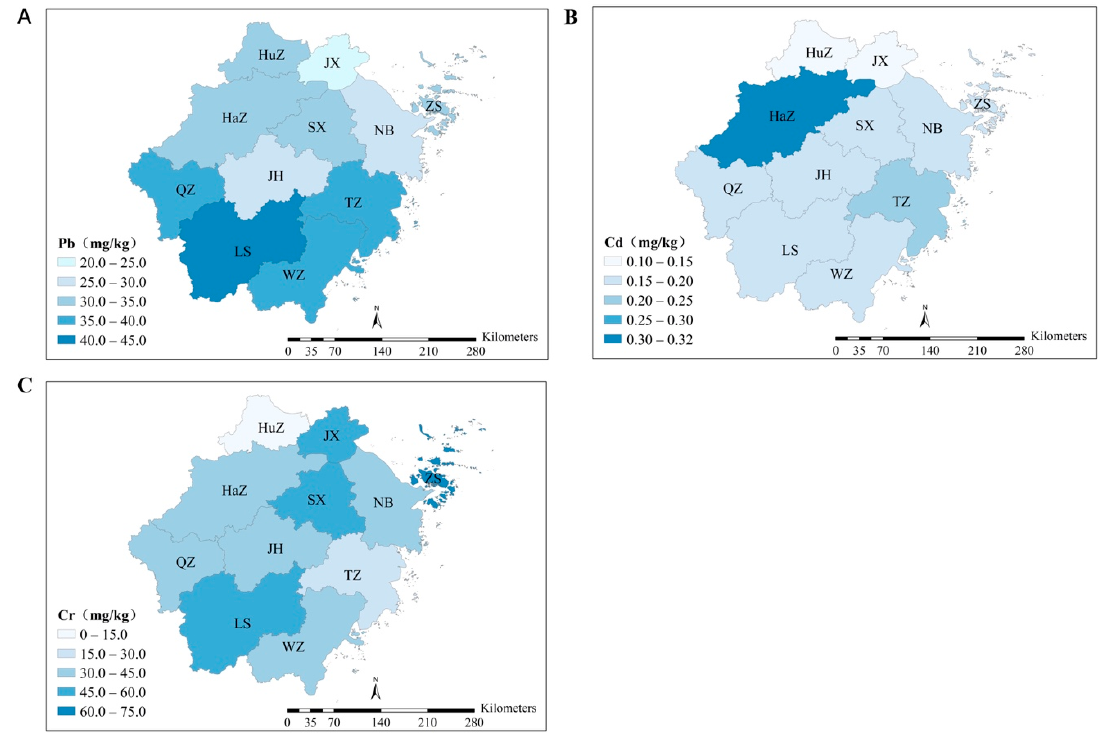
Figure 2. Average concentrations of heavy metals in agricultural soils in various cities in Zhejiang Province. ( A ): Average concentrations of Pb in agricultural soils in various cities in Zhejiang Province. ( B ): Average concentrations of Cd in agricultural soils in various cities in Zhejiang Province. ( C ): Average concentrations of Cr in agricultural soils in various cities in Zhejiang Province.